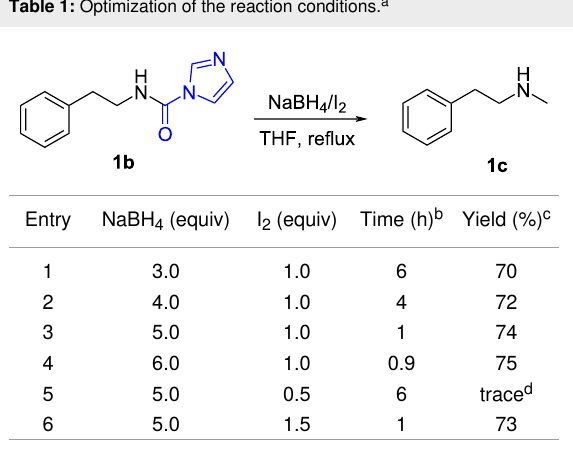
Table 1: Optimization of the reaction conditions.